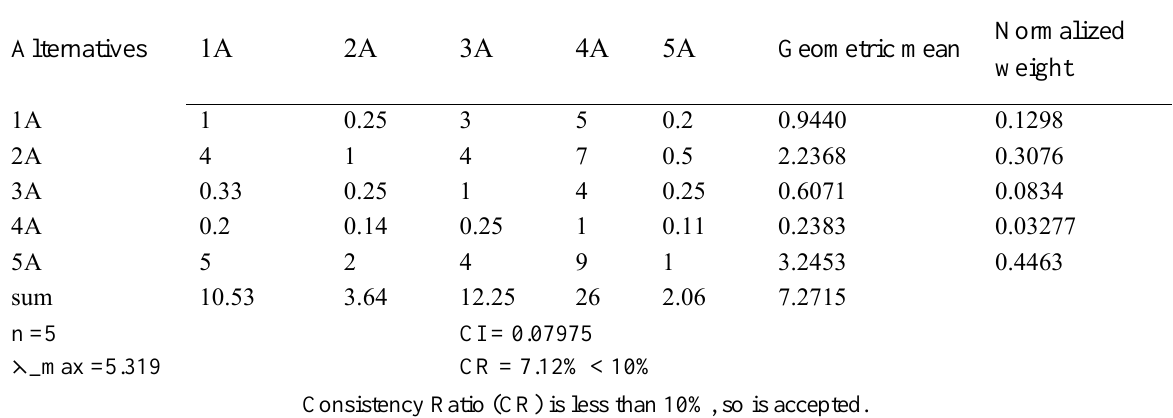
Table 14. Comparison Matrix of Alternatives with respect to C10.